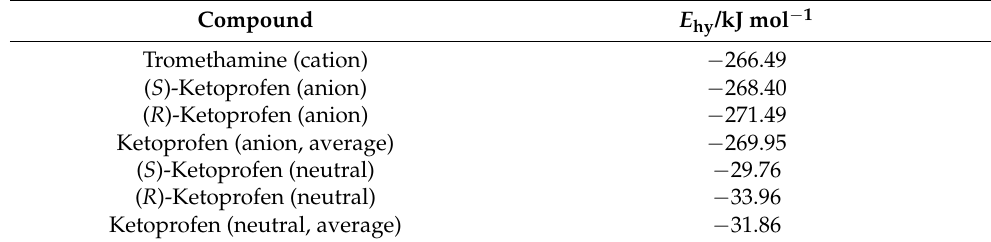
Table 3. Hydration energies of tromethamine and